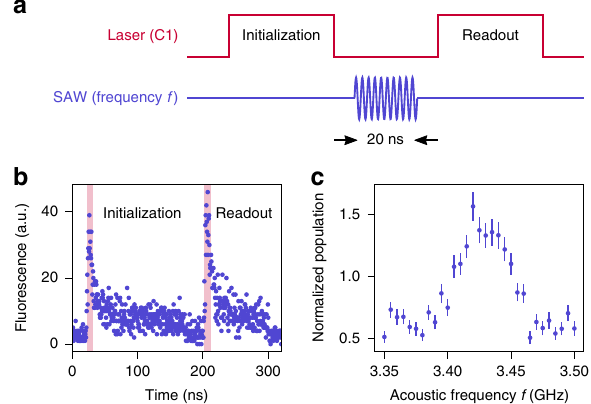
Fig. 3 Optically detected acoustic resonance (ODAR) measurements of the SiV spin transition. a Optical and acoustic pulse sequences used for ODAR measurement. The laser is resonant with the C1 transition and initializes the SiV into "j i . A 20 ns duration SAW pulse drives population between "j i and #j i . b Time-resolved histogram of photon detection events corresponding to the pulse sequence in a . The height of the peaks at the beginning of the initialization and readout pulses is proportional to the population in #j i . Photon detections are integrated over 10 ns (indicated by the shaded region) to determine initialization and readout signals. c Normalized population in the #j i state as the center frequency of the acoustic pulse is varied, calculated as the ratio between the readout and initialization signals. A maximum is obtained at 3 : 43 GHz, indicating the resonance frequency of the SiV spin transition. The error bars represent the standard deviation of the normalized